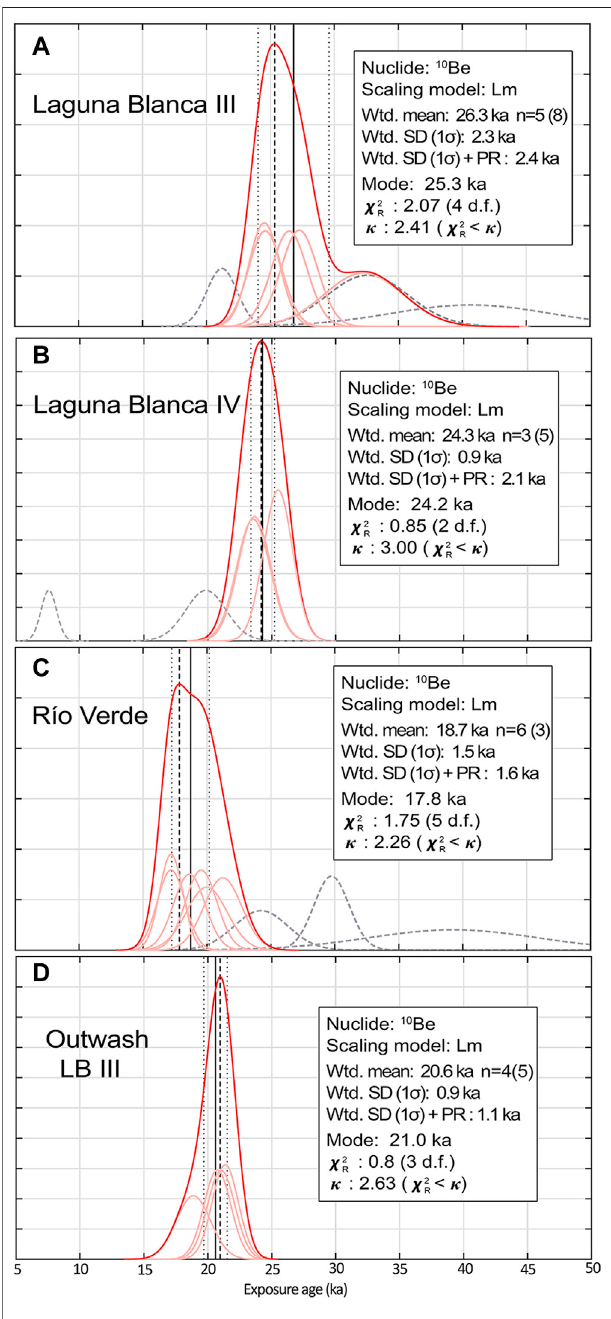
FIGURE 8 | Probability density functions ( “ camel plots ” ) of the ages for morainesandoutwashoftheformerSkyringicelobe.Allagesarecalculatedwith the Patagonian production rate from Lago Argentino (Kaplan et al., 2011) and considering zero erosion. (A) Laguna Blanca III. (B) Laguna Blanca IV. (C) Río Verde moraine. (D) Outwash Laguna Blanca III. n corresponds to the number of samples used to calculate the weighted ages. Bracket numbers are all the samples processed, including outliers. The diagrams were plotted using IceTea(Jonesetal.,2019),wherethemode(blackdashedline),weightedmean (solid black line) and weighted standard deviation (SD; black dotted lines) of the datasetareshown.Theapplicationalsocalculatesthereducedchi-squared( χ 2 R ) andtheassociatedcriterion( κ ).Theoutliersareshownasgreydashedlines;they were calculated following reduced chi-squared